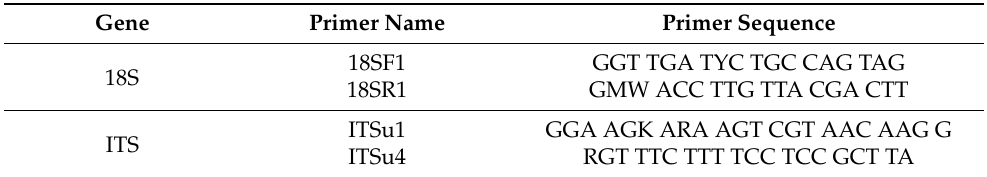
Table 1. Target genes and primers used for the 18S [62] and ITS [63] regions.